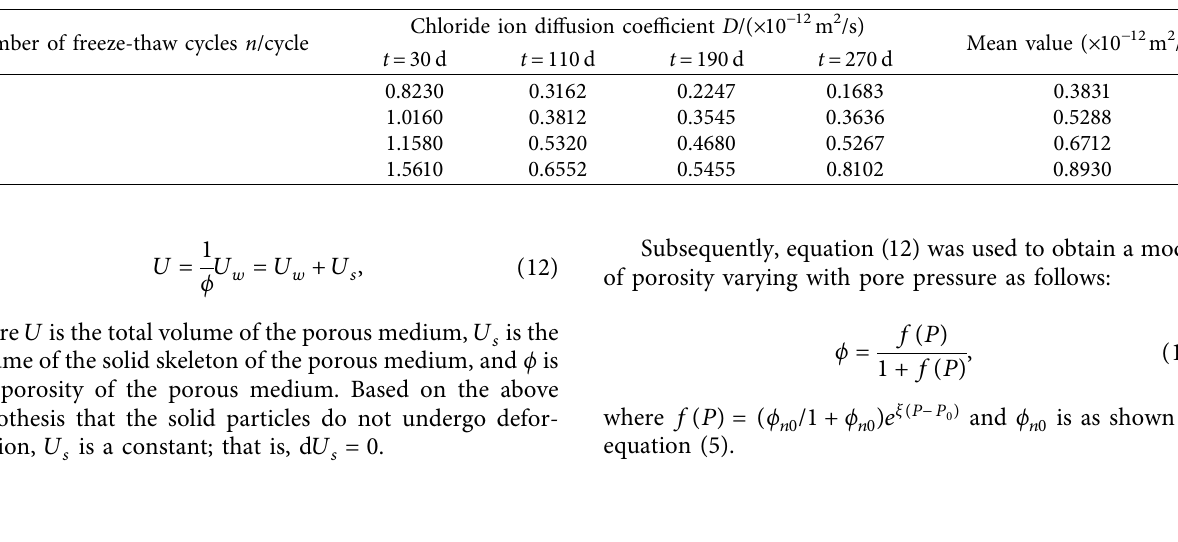
Figure 4: Variation pattern of concrete chloride ion concentration ( c ) with depth ( l ) after freeze-thawing. (a) t � 30d. (b) t � 110d. (c) t � 190 d. (d) t � Table 2: Chloride ion diffusion coefficient D .